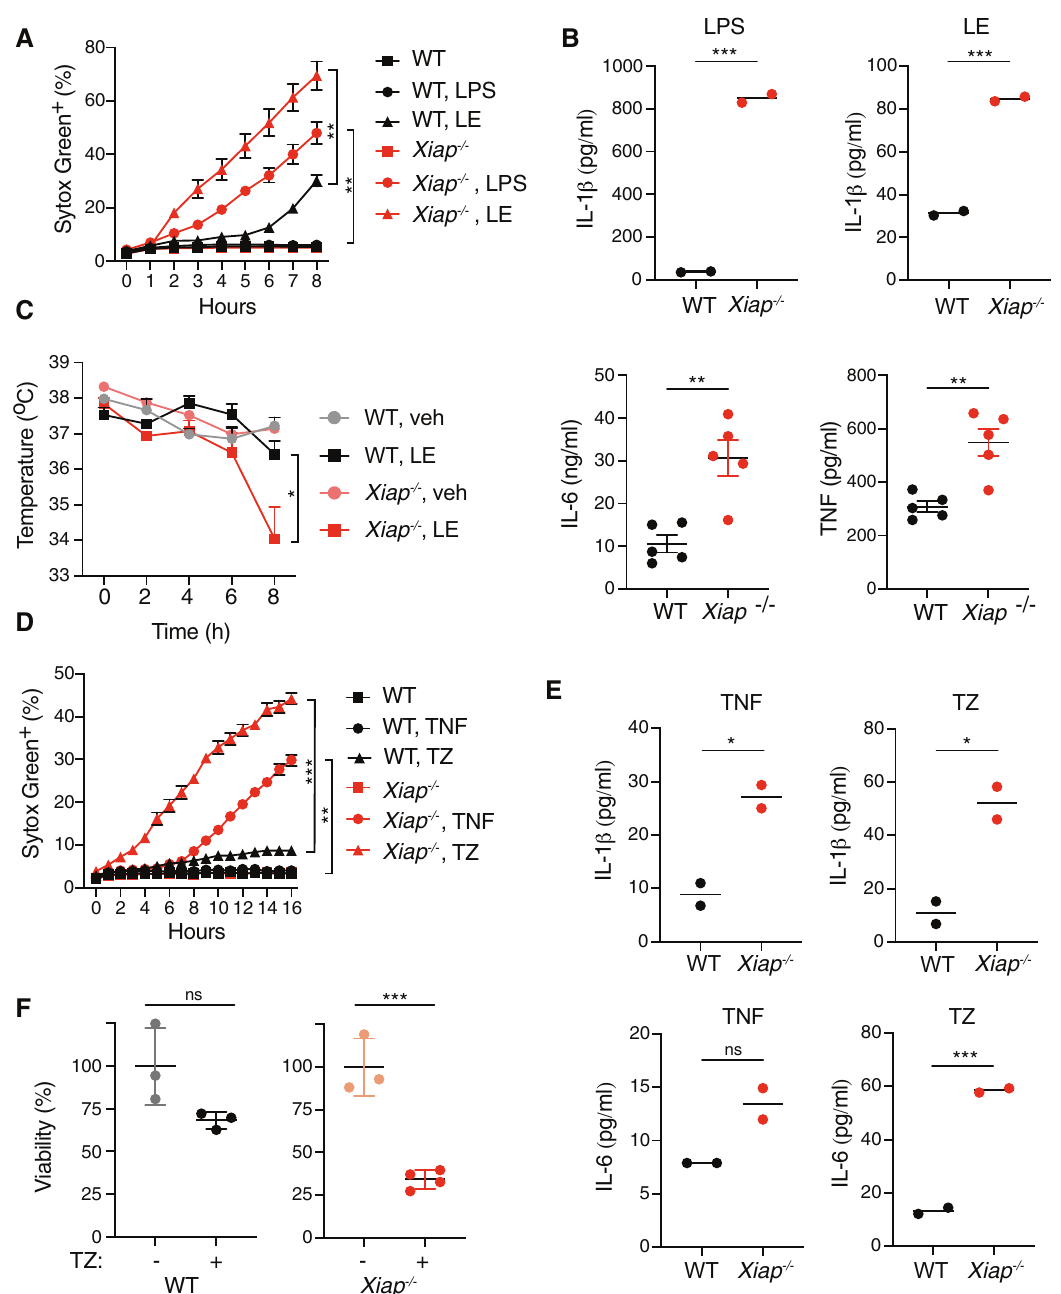
Fig. 1 XIAP de fi ciency enhances LPS and TNF mediated cell death. A BMDMs derived from WT or Xiap − / − mice were treated with LPS or LPS and Emricasan (LE). Percentage of dead BMDMs (Sytox Green positive cells) compared to positive control. Signal was measured every hour in the Incucyte with the indicated treatments: LPS 100 ng/ml, Emricasan 5 μ M. ( n = 5 for WT non-treated control, n = 6 for all others). B IL-1 β release from indicated BMDMs ( n = 2) treated with 100 ng/ml LPS or LPS and 5 μ M Emricasan (LE) for 8 h. C LPS and Emricasan (LE) induced hypothermia (left), WT ( n = 5 mice for vehicle and n = 15 for LE) and Xiap − / − ( n = 5 mice for vehicle and n = 18 for LE) and release of IL-6 and TNF at 8 h (right), WT ( n = 5) and Xiap − / − ( n = 5) mice. D BMDMs derived from WT or Xiap − / − mice were treated with TNF (50 ng/ml) or TNF and zVAD (20 μ M) ( n = 6 for each treatment). Cell death was performed as described for A . E IL-1 β and IL-6 release from indicated BMDMs ( n = 2) treated with 50 ng/ml TNF or TNF and zVAD (TZ) for 8 h. F Intestinal organoids derived from WT or Xiap − / − mice were treated with TNF and zVAD (TZ) (for Xiap − / − TZ treatment n = 4, for all other treatments n = 3 mice). Viability was determined 24 h later using MTT assay. In A , C , D , bars indicate median with standard error, in B , E median, in F mean with standard deviation. Ns indicates no signi fi cance, * p < 0.05, ** p < 0.01, *** p <